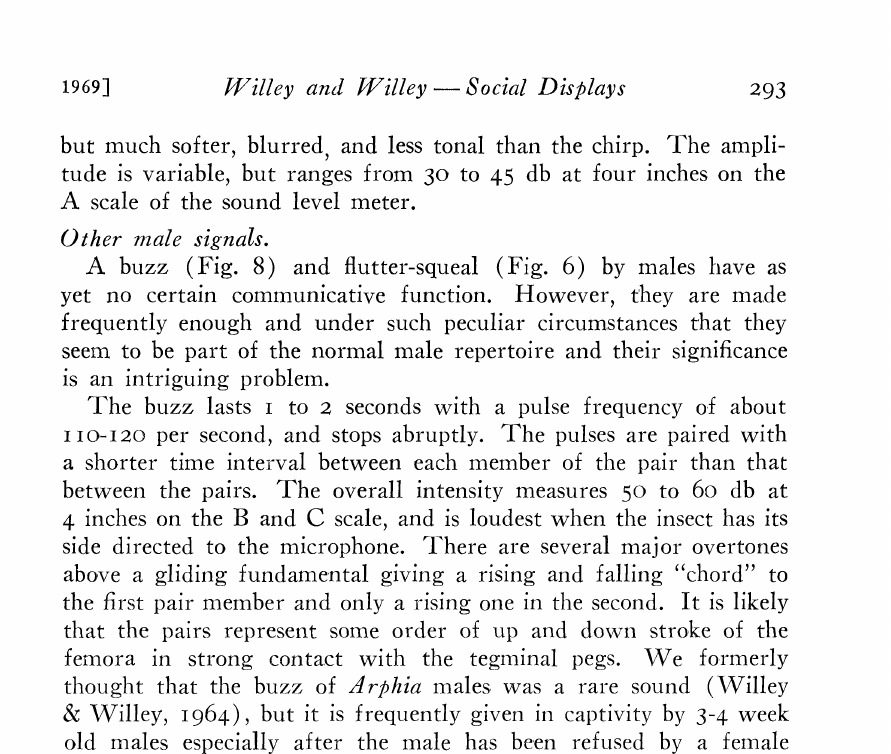
Figure 8. Field recording of entire buzz with an after-stroke resembling a very brief chirp. Note the paired nature of the strokes, sharp frequency and amplitude peaks, the even double pulse rate, increase in frequency peaks and their variability, and the abrupt beginning and ending of the song. The high frequency "ghosts" peaking at 12 t 16-{- KHz probably represent an artifact of the spectrograph. Figure 9. Laboratory recording of flutter rasp between two males. The first three pulses were delivered by a normal male using both hind legs, the train of double strokes was given by a one-legged male obviously contacting the tegminal file on both up and down strokes. One of the pair of strokes is identical to that one given by the two-legged male, indicating temporal precision in deployment of the two legs making that stroke. The second of the paired strokes resembles a single pulse of the buzz in its frequency peak characteristics. There is considerable variation in the time spacing of the strokes. Again, the "harmonies" are probably largely due to spectrograph artifact based on the basic pulse repetition rate of the fundamental